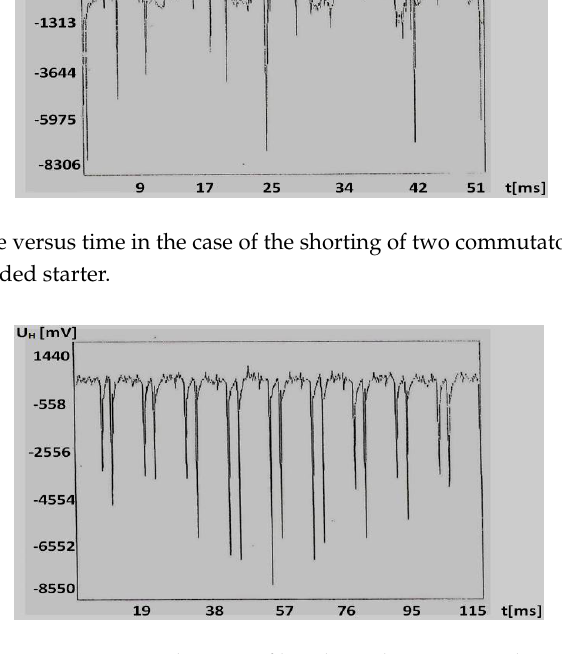
Figure 15. Hall voltage versus time in the case of breaking the rotor winding integrity, Hall sensors fixed on the rotor, unloaded starter.